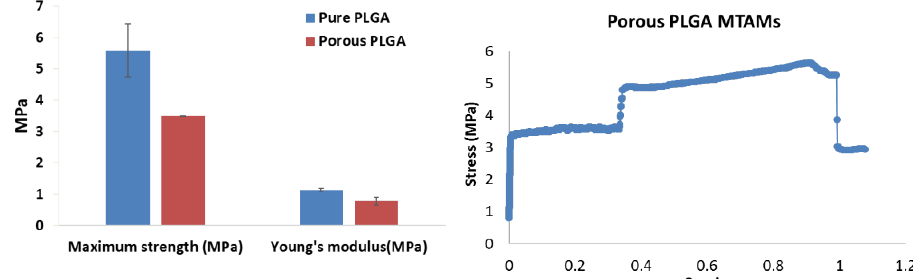
Figure 3. Mechanical properties (stress–strain curve) of PLGA MTAMs. The maximum tensile strength of the porous PLGA MTAMs used in the TEVG was recorded at 3.48 ± 0.06 MPa, while the Young’s Modulus registered a reading of 0.778 ± 0.13 MPa ( left ). The stress–strain (SS) curve of the porous PLGA MTAMs ( right ). A relatively sound mechanical TEVG with excellent Young’s modulus would prove to be significantly beneficial to the application